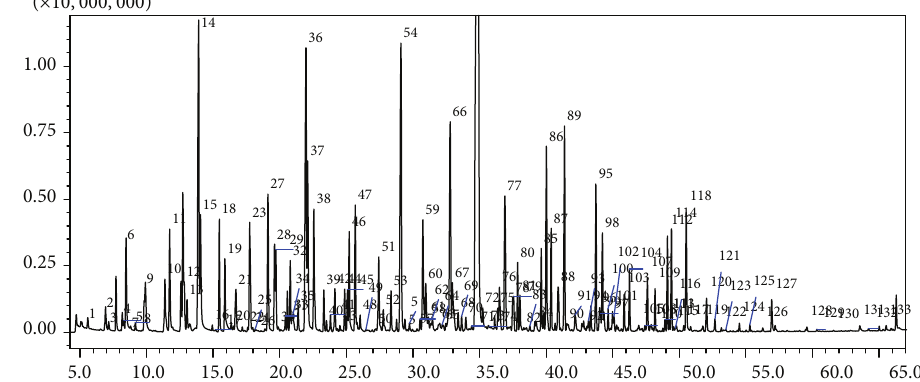
Figure 2: Total ion current (TIC) chromatogram of the HS-SPME volatile compounds of Cape